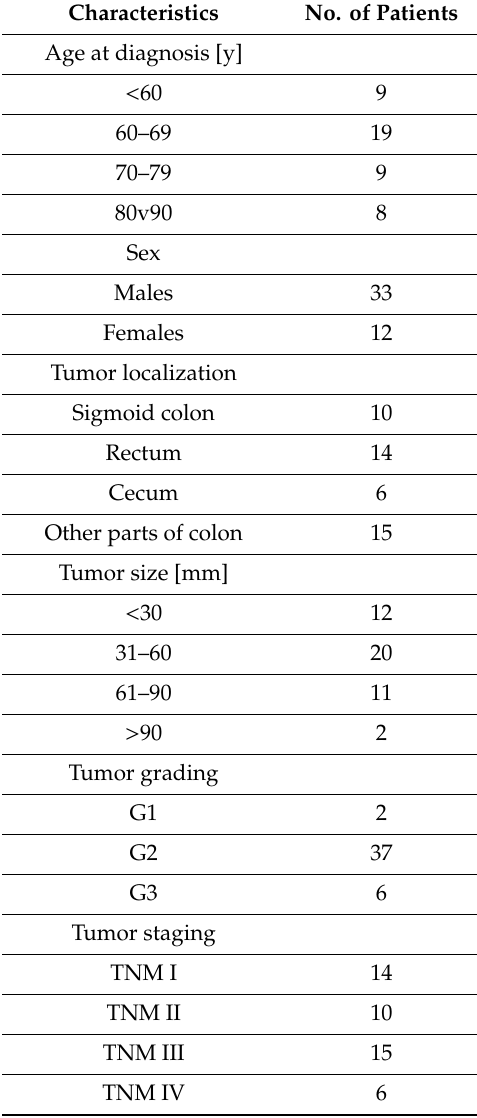
Table 1. Demographics and clinical characteristics of colorectal cancer (CRC)